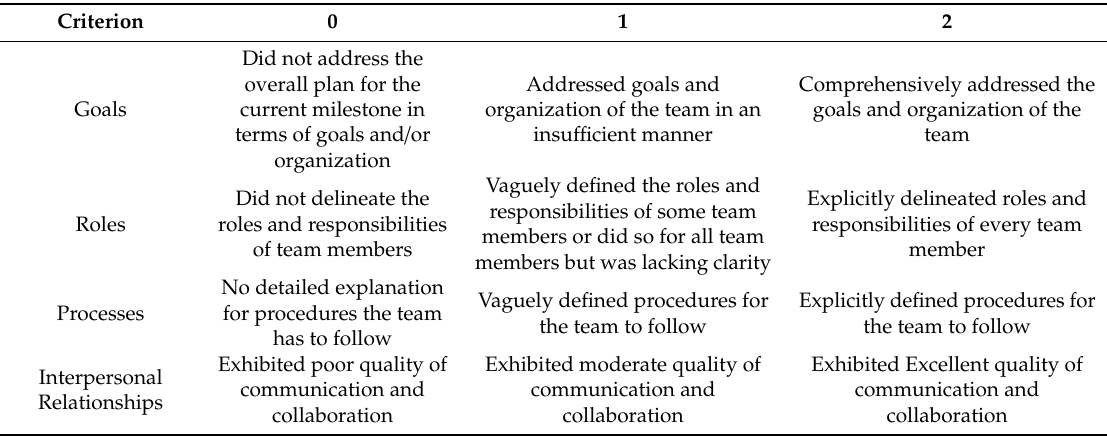
Table 2. Rubric representing the definition and scores for each level.